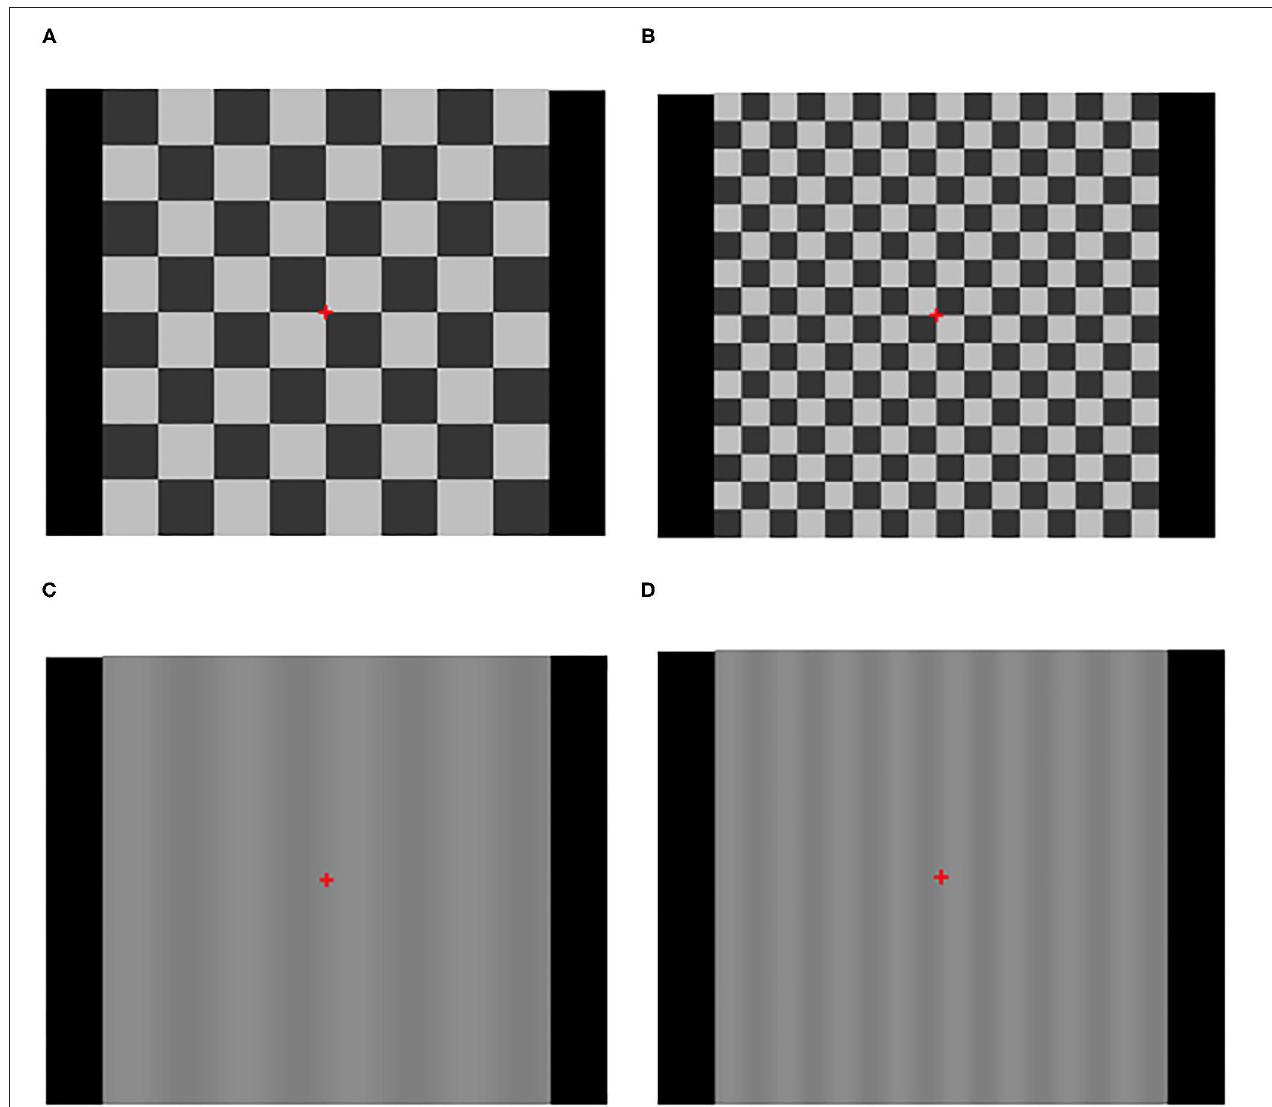
FIGURE 1 | VEP stimuli using checkerboard patterns at 85% contrast and vertical sinusoidal gratings (VSG) at 10% contrast. (A) 8 × 8 checkerboard (119.4 MOA checks). (B) 16 × 16 checkerboard (59.7 MOA checks). (C) 8 VSG (119.4 MOA-wide columns). (D) 16 VSG (59.7 MOA-wide columns).